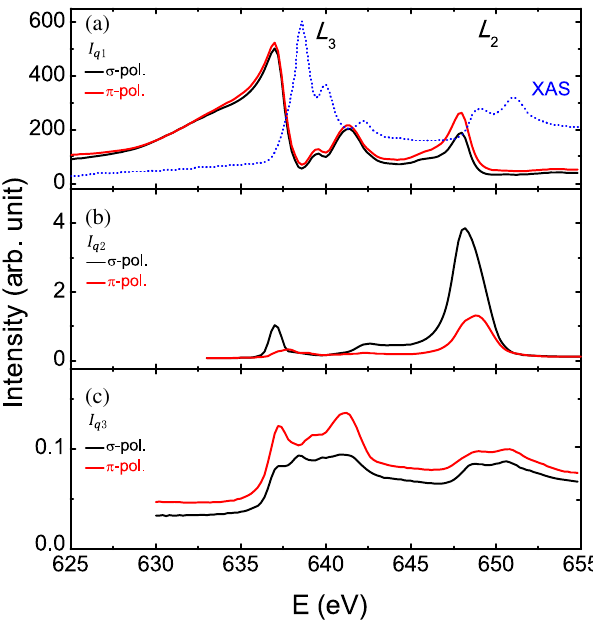
FIG. 4. q -integrated intensity I q of the three resonance peaks shown in Fig. 3. (a) I q 1 with σ (black line) and π (red line) polarizations. I q 2 and I q 3 are plotted in (b) and (c),